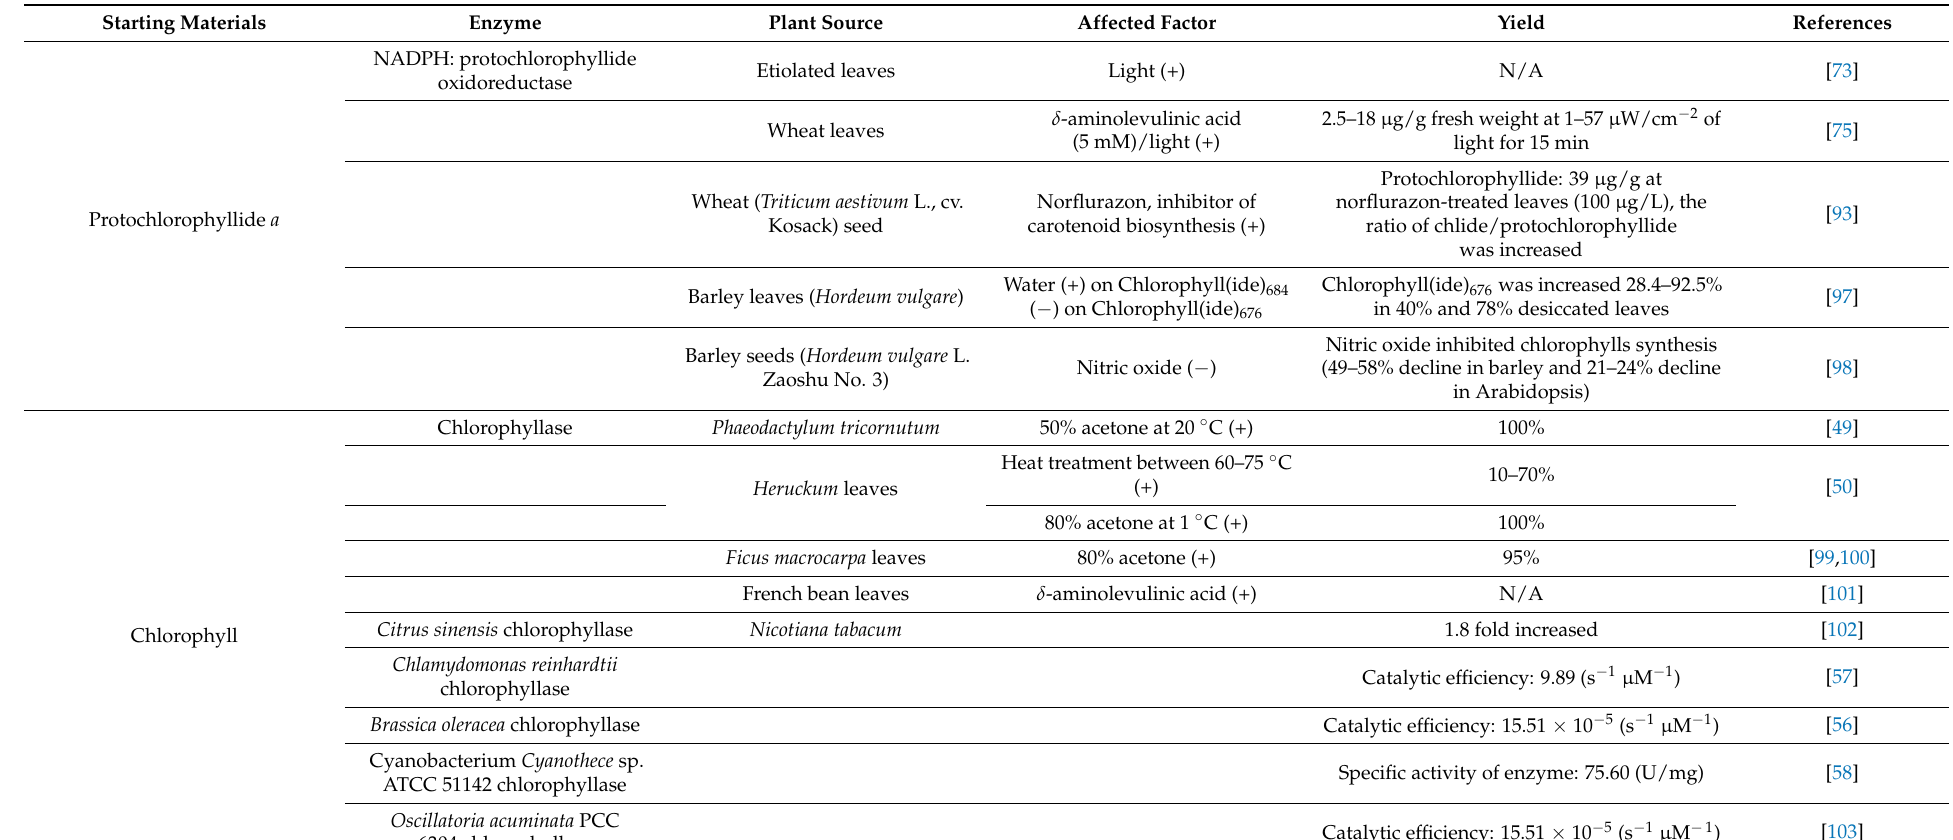
Table 2. Some examples of chlorophyllides synthesis from protochlorophyllide and